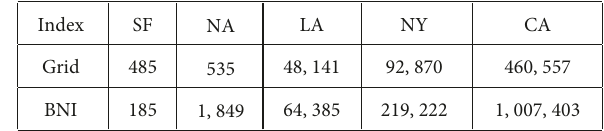
Figure 11: Index construction time (second).